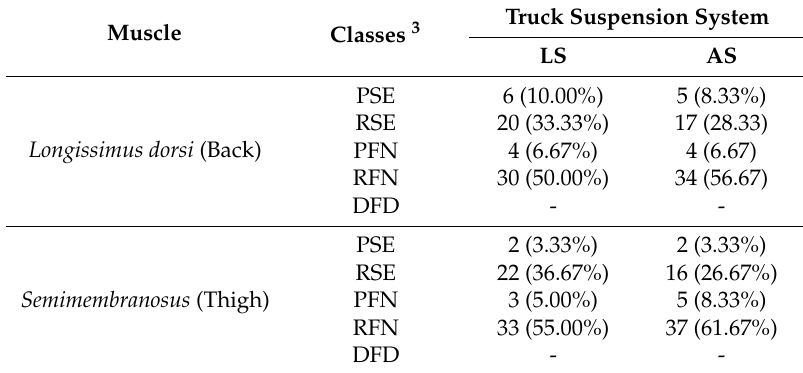
Table 5. Meat quality classification 1 according to effect of truck suspension system (LS or leaf-spring suspension vs. AS or air suspension system) as assessed in the Longissimus dorsi and Semimembranosus muscles 2 . Truck Suspension System Muscle Classes 3 LS